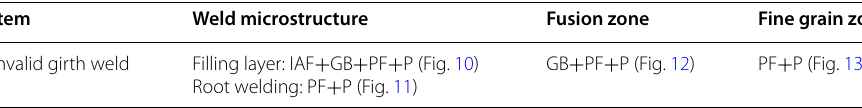
Item Weld microstructure Fusion zone Fine grain zone Invalid girth